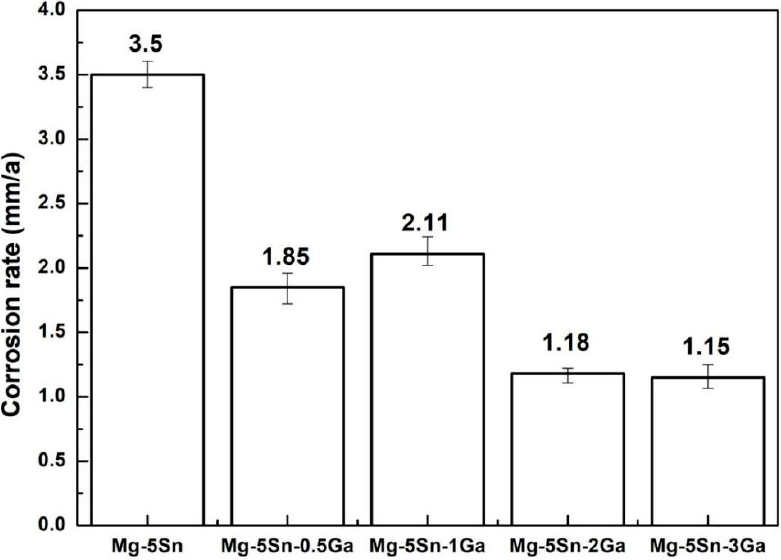
Figure 6. Average corrosion rate of the Mg–5Sn– x Ga alloys after immersion in 3.5 wt % NaCl solution for 72 h.